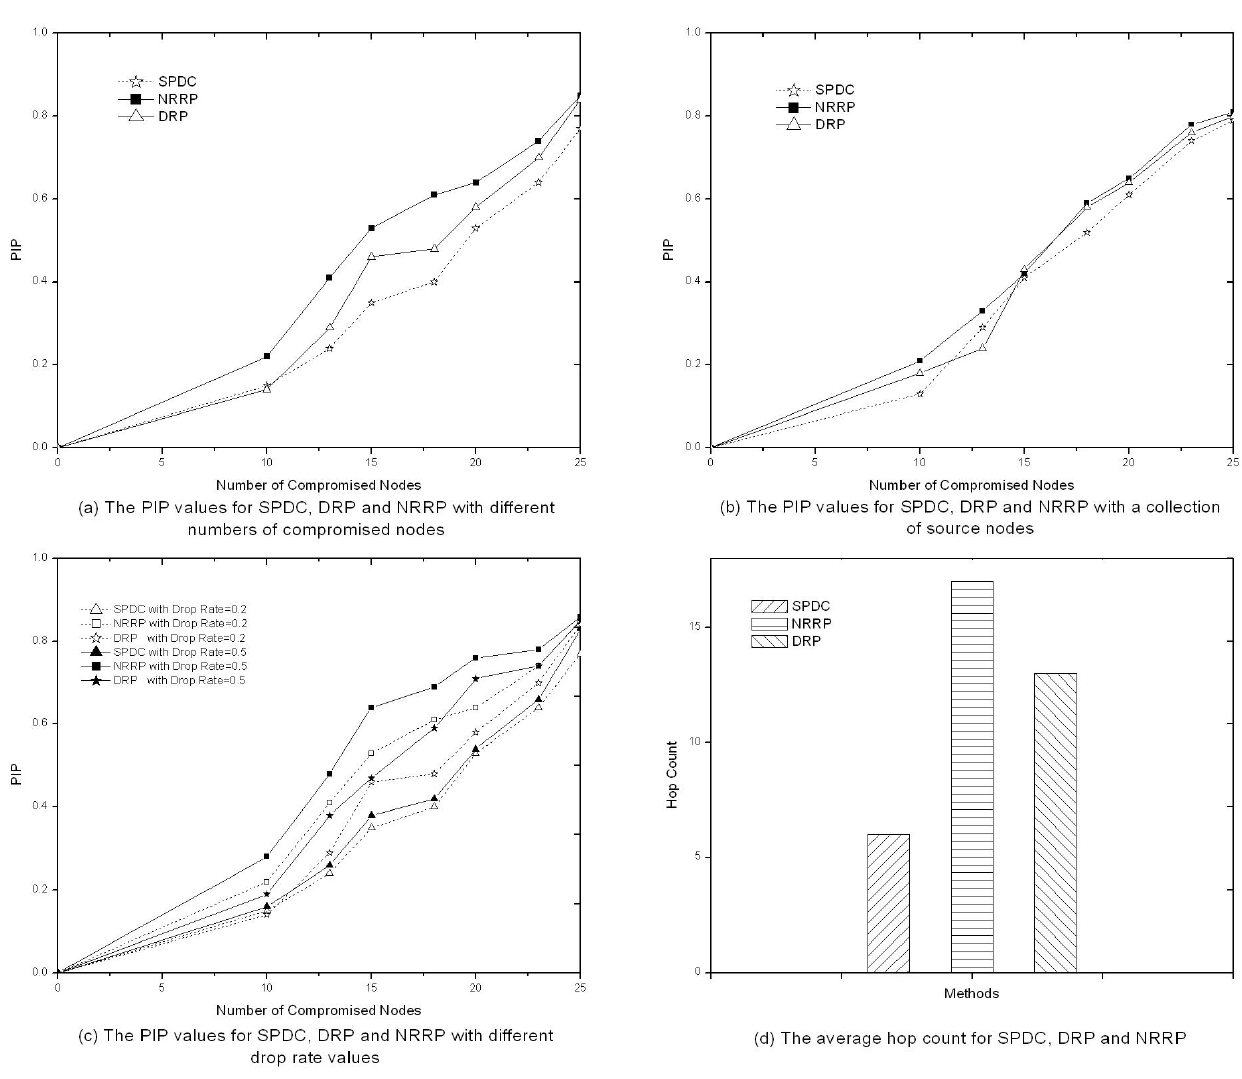
Figure 6. The simulation results for the performance evaluation of SPDC.